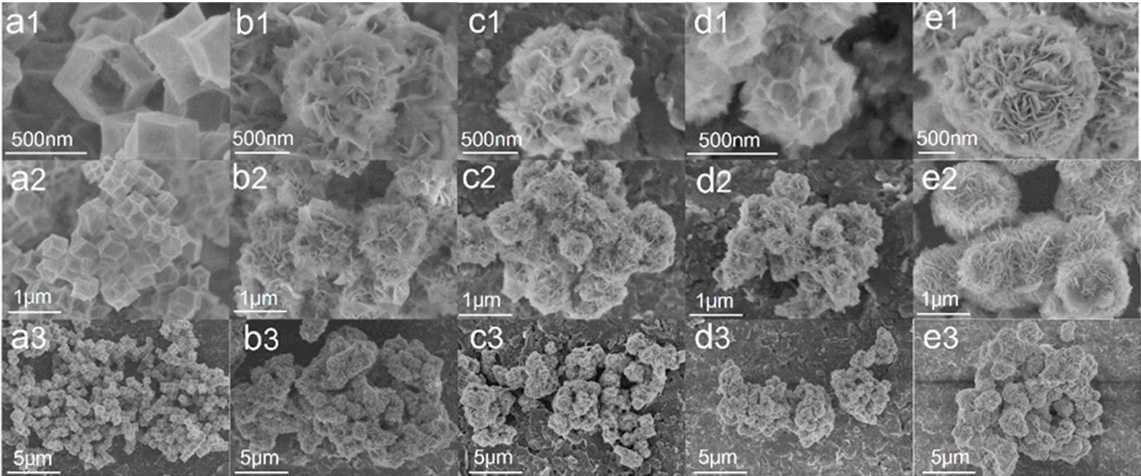
Figure 3. Field emission electron micrographs of all samples at different magnifications: ( a1 – a3 ) Co 3 O 4 ; ( b1 – b3 ) Co 3 O 4 (10)@ZIS; ( c1 – c3 ) Co 3 O 4 (20)@ZIS; ( d1 – d3 ) Co 3 O 4 (40)@ZIS; ( e1 – e3 ) ZnIn 2 S 4 .